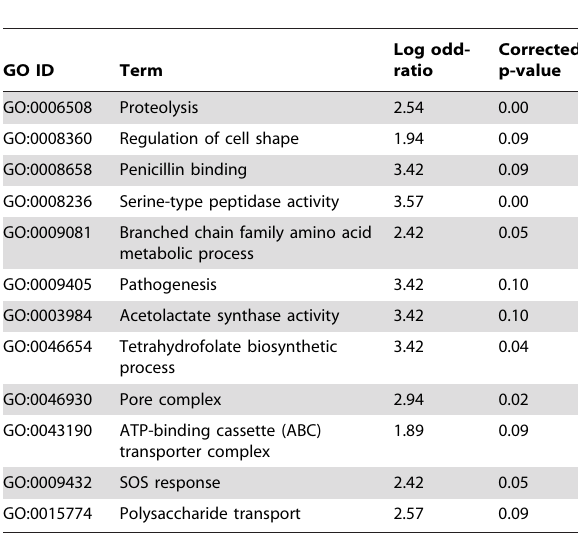
Table 4. Gene Ontology terms enriched in the depleted gene